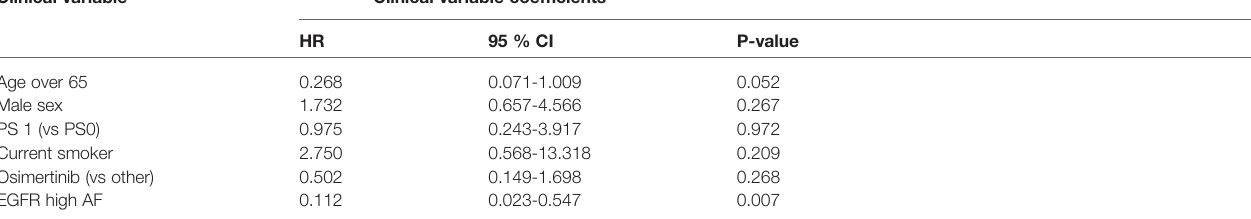
TABLE 1B | Multivariable PFS.